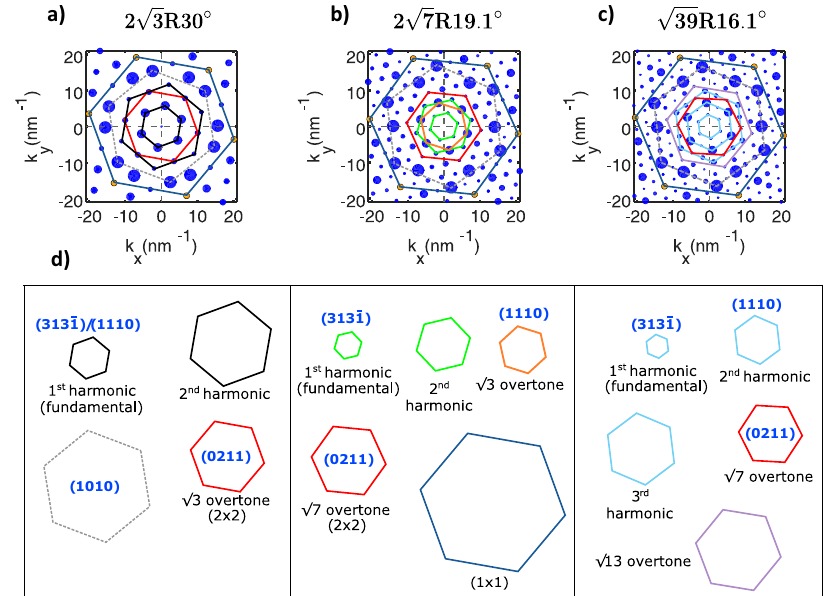
! mnpq Moiré reciprocal vectors (blue dots) of the corresponding